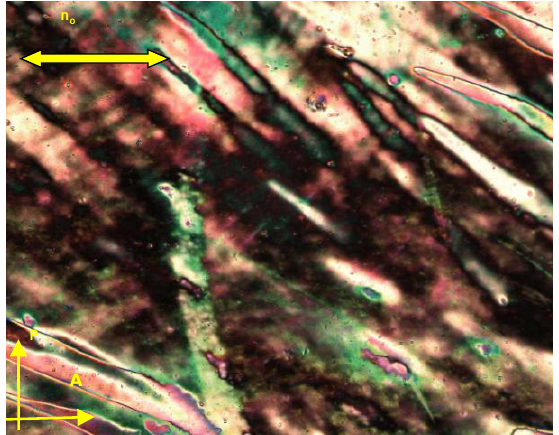
Figure 8. Textures of the nematic phase of 2 between untreated glasses observed between crossed